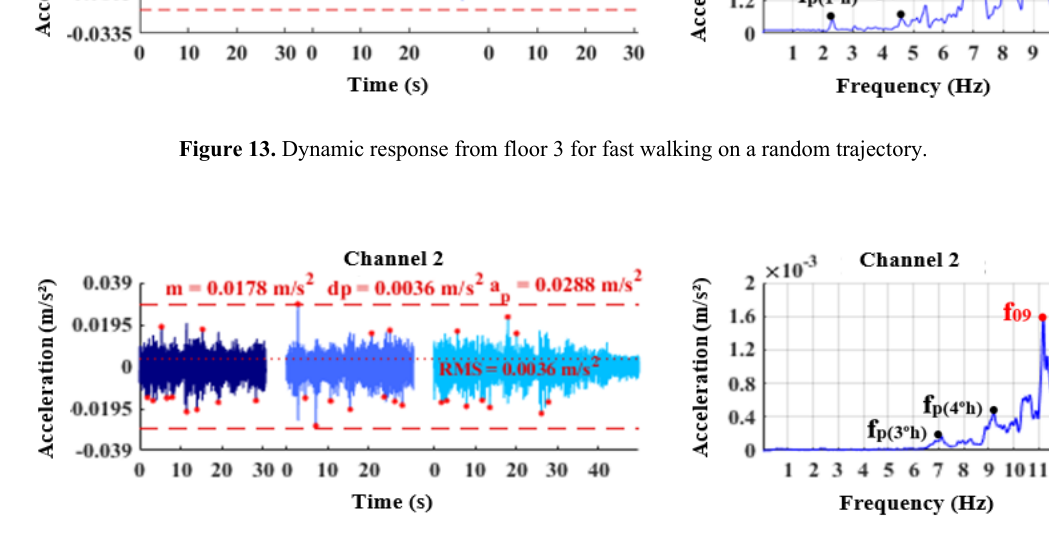
Figure 14. Dynamic response from floor 4 for fast walking on a random